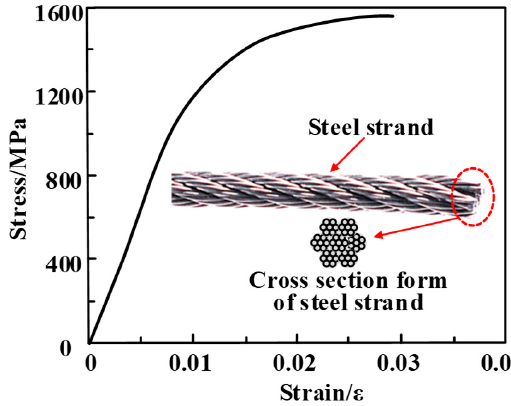
Figure 6. Tensile test of steel strand.